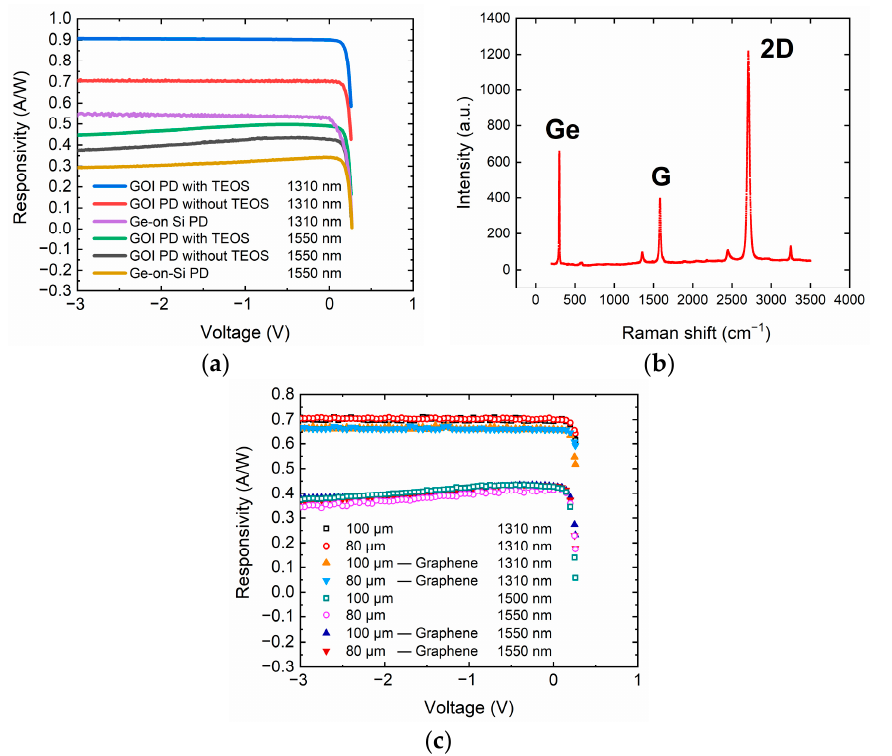
Figure 5. ( a ) Responsivity–voltage characteristics for illuminated PDs with a diameter of 80 μ m on three types of detectors. ( b ) Raman spectra of transferred graphene on the detector. ( c ) Responsivity–voltage characteristics for illuminated GOI PDs (without TEOS) with or without graphene on the surface.